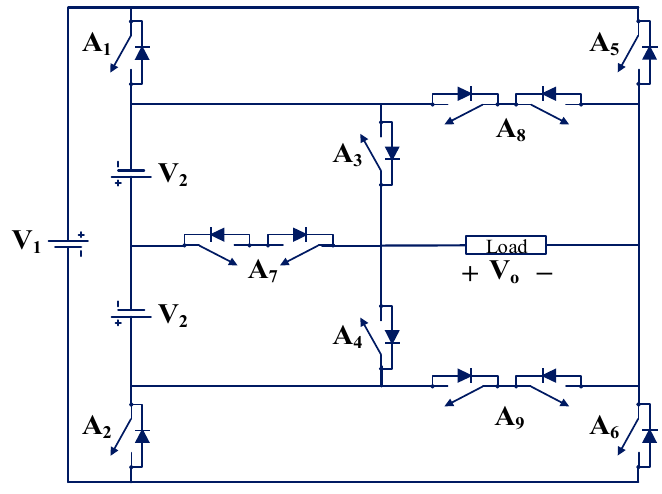
Figure 20. Single-phase eleven-level FT MLI (TP21) [56].